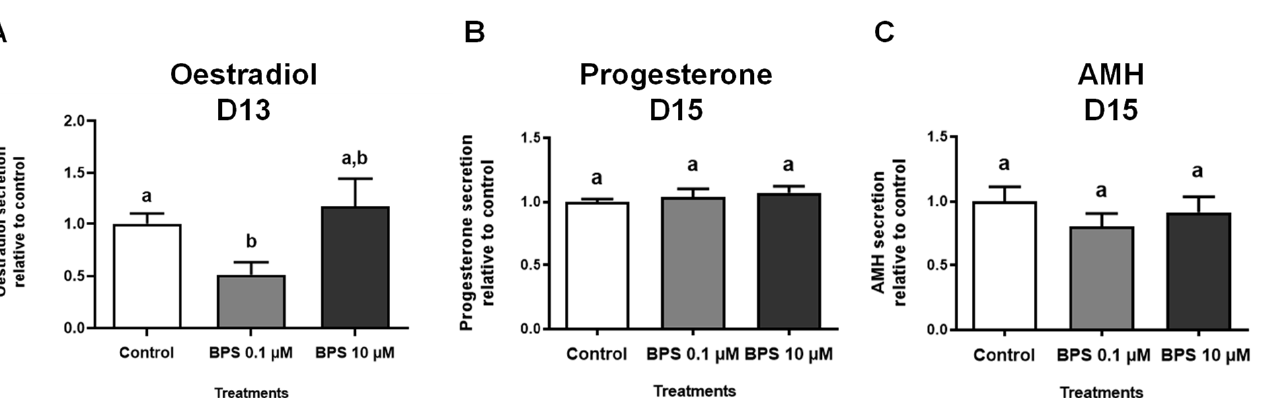
10 of 21 Figure 2. In vitro effects of bisphenol S (BPS) on ovine follicular growth and antrum appearance. The diameter evolution ( A ) and the antral cavity appearance ( B ) for each alive follicle were assessed after 6, 13 and 15 days of treatment with or without BPS 0.1 μ M or BPS 10 μ M. The results are representative of seven independent cultures with eight replicates per condition ( n = 56 per condi- tion at day 0, n = 48–53 according to the conditions at day 6, n = 40–42 according to the conditions at day 13 and n = 38–39 according to the conditions at day 15). For the diameter evolution, the results